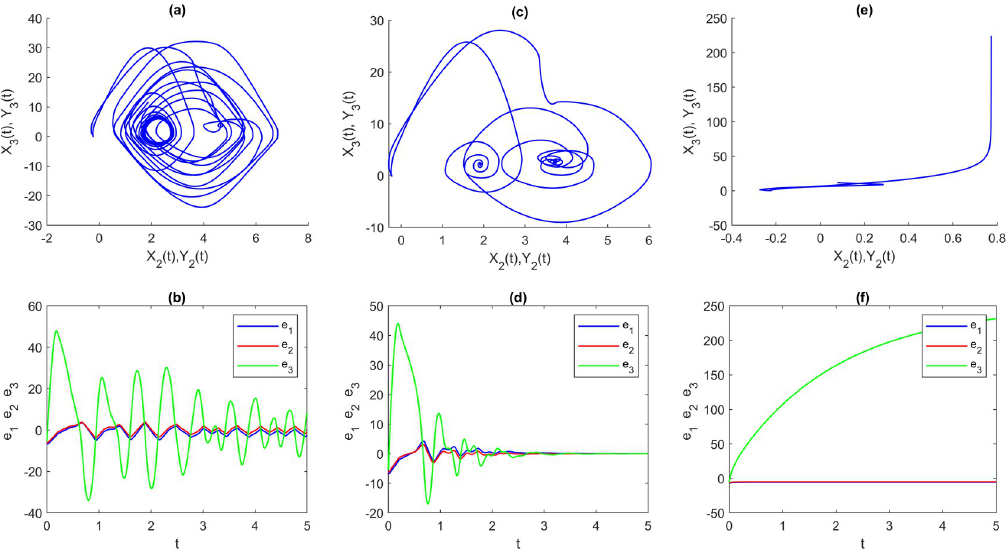
Fig 8. Multi time-varying delay of multi-FONNSMD synchronization with different value of parameters. (a) A = P = diag[1 1 1], (b) A = diag[1 2 2], P = diag[2 2 2], and (c) A = diag[10.5 10.5 0.5], P = diag[20.5 20.5 20.5]. (a), (c) and (e) are synchronization of FONNSMD systems while (b), (d) and (f) are dynamic error of FONNSMD systems.